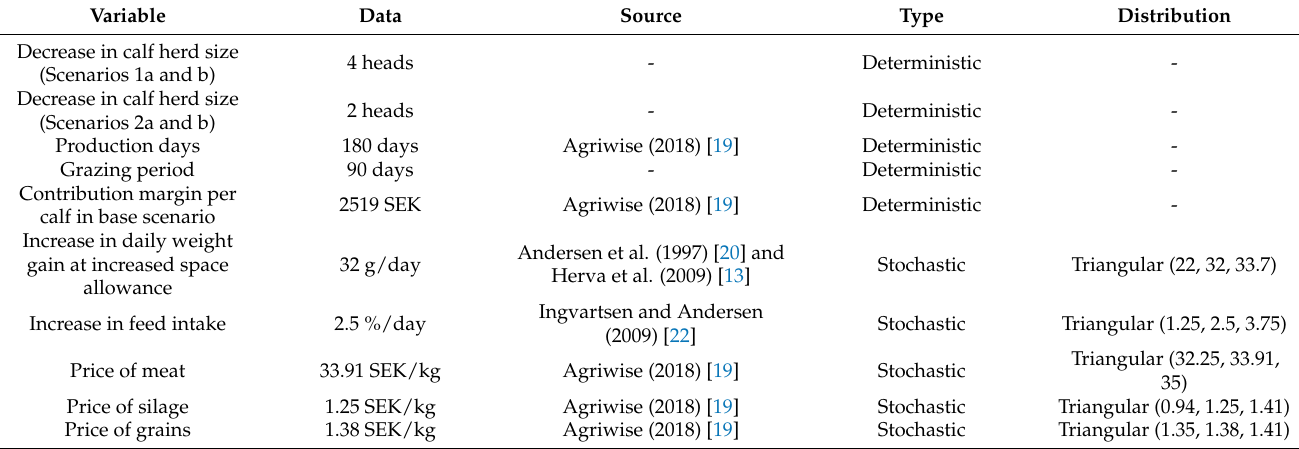
Table 1. Overview of the variables used in partial budget models for increased space allowance (from 2.2 to 2.7 m 2 /calf).